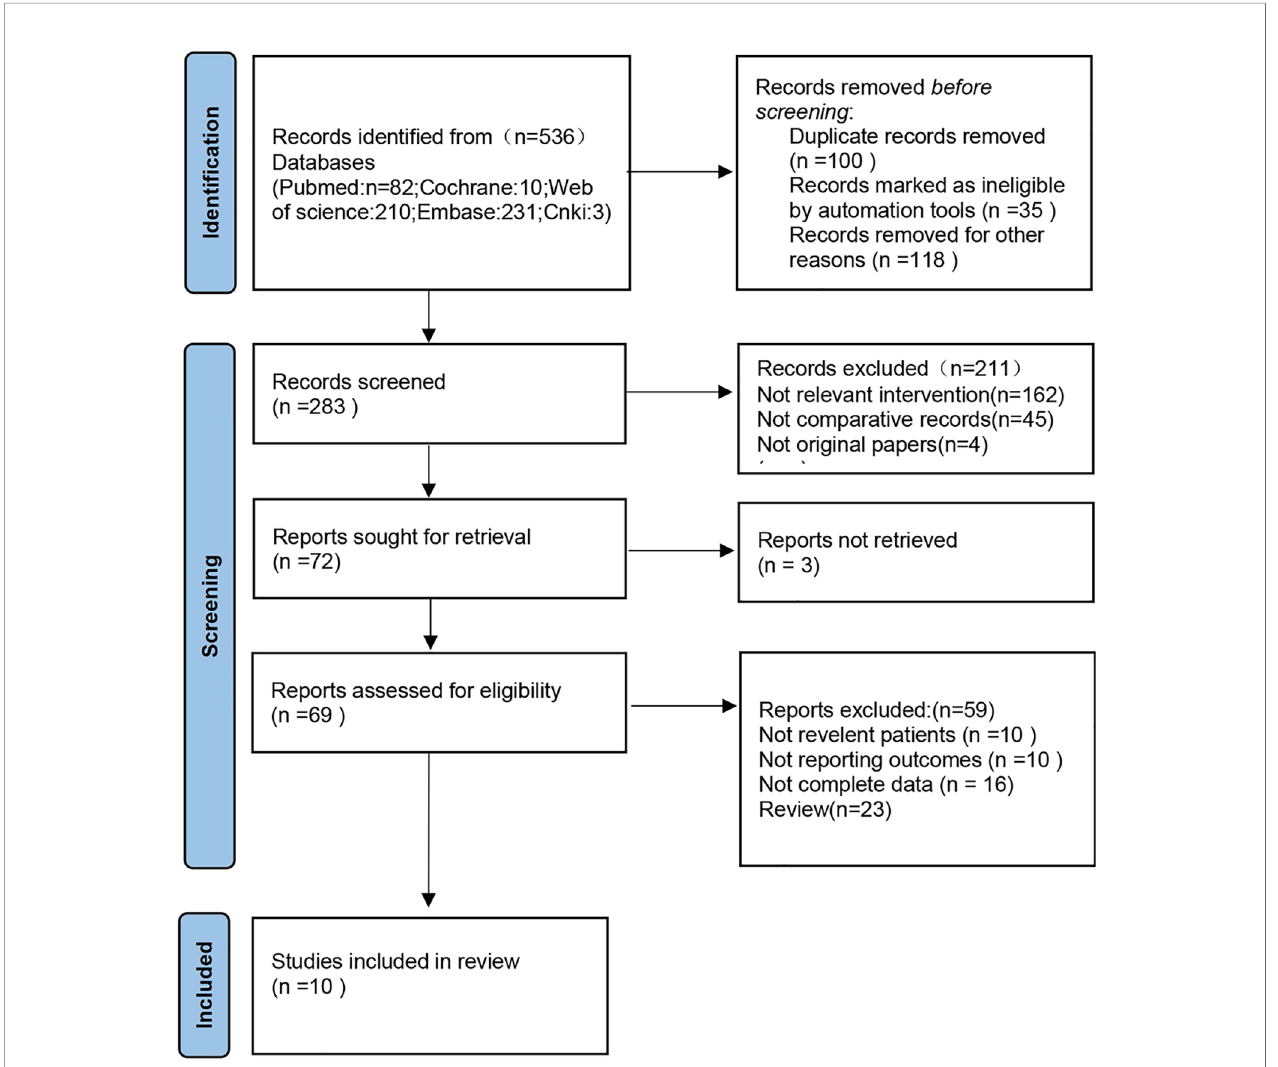
FIGURE 1 | Flow diagram of studies identi fi ed, included and